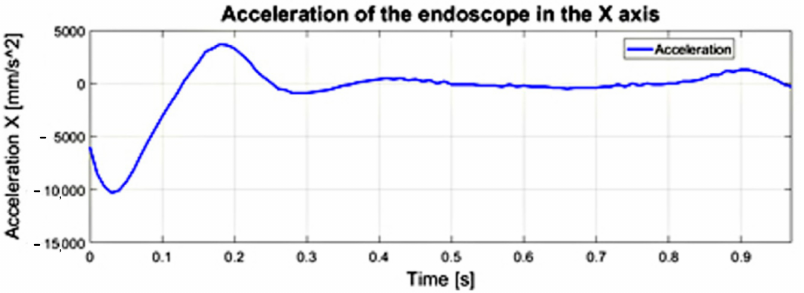
Figure 18. The acceleration course of the endoscopic tool along the X − axis. The figure illustrates the acceleration fluctuations.